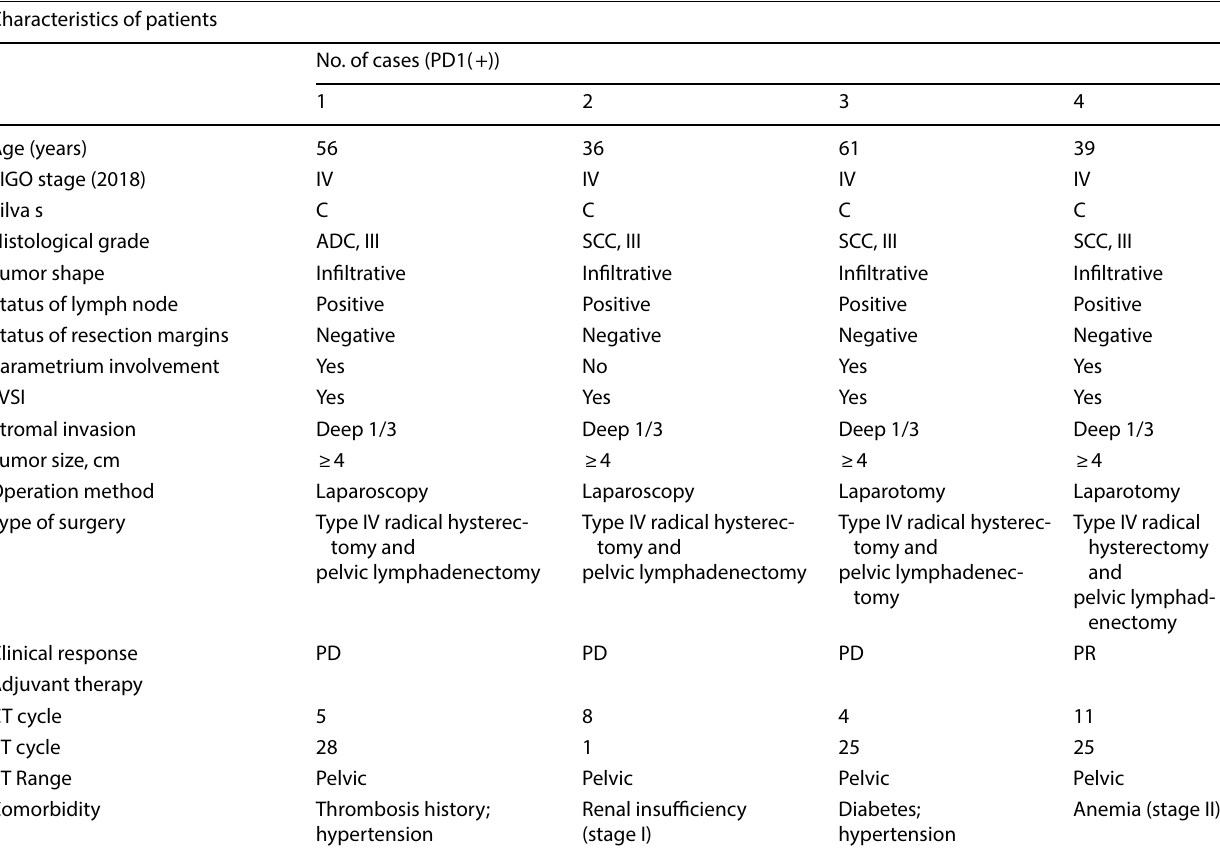
Middle 1/3, Deep 1/3; CT chemotherapy; RT